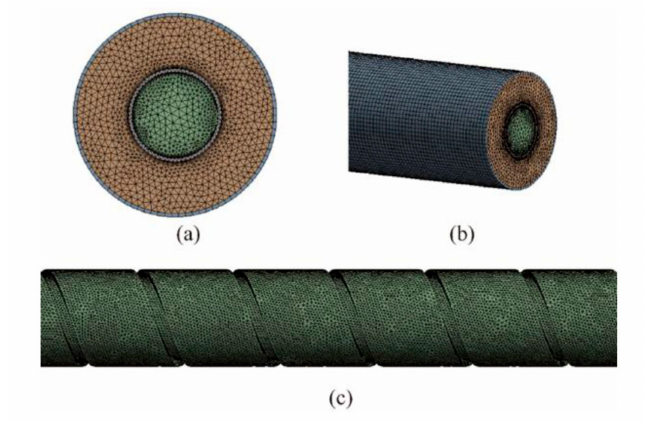
Figure 2. Grid structure of the corrugated